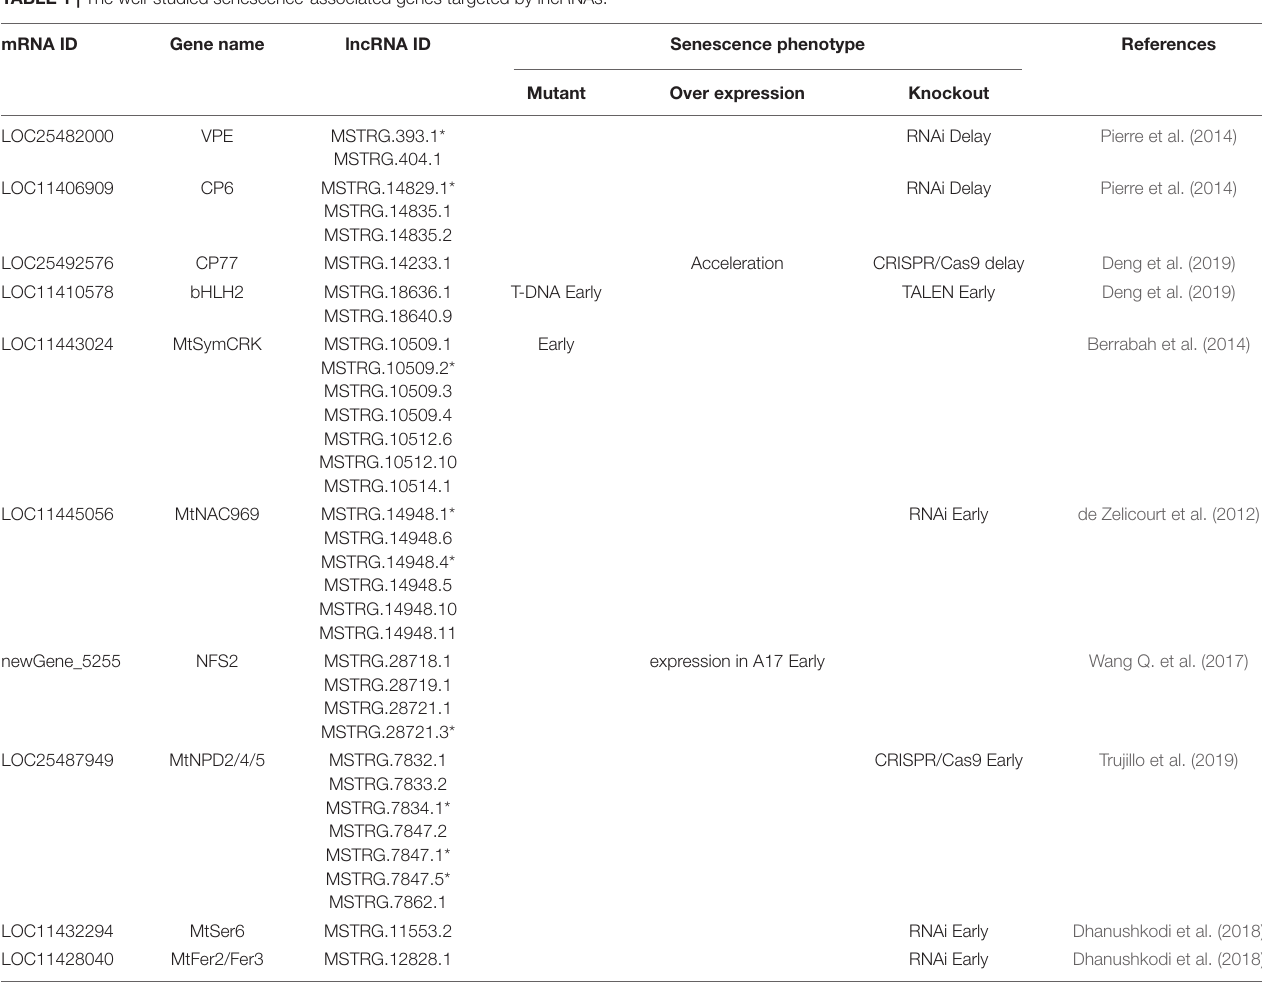
TABLE 1 | The well-studied senescence-associated genes targeted by